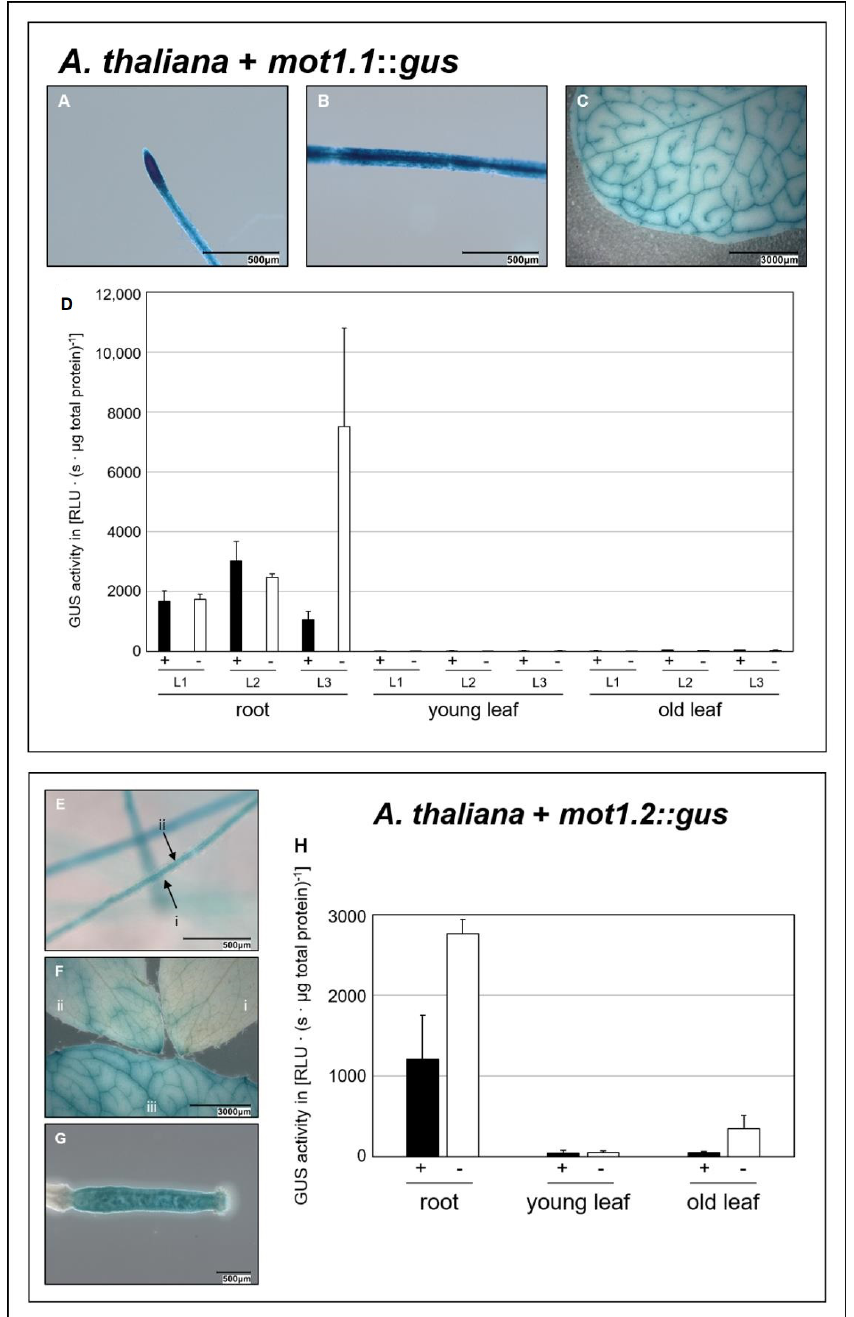
Figure 2. Organ specific expression patterns of mot1 family members. Histochemical GUS assay of transgenic A. thaliana carrying mot1.1::gus ( A – C ). Root tip ( A ), mature root ( B ), and old leaf ( C ) are shown. Histochemical ( E – G ) GUS assay of transgenic A. thaliana carrying mot1.2::gus showing mature root (( E ); i = unstained root periphery, ii = stained central cylinder), rosette leaves of increasing age (( F ); (i) young, (ii) middle-aged, (iii) old) and developing fruit ( G ). Scale bars = 500 µm ( A , B , E , G ) and 3000 µm ( C , F ). Fluorimetric GUS assay ( D , H ) showing GUS activity of three independent (L1 – L3) mot1.1::gus plant lines and one mot1.2::gus line grown with molybdate availability (+) and deprivation ( − ) in roots, young and old leaves.